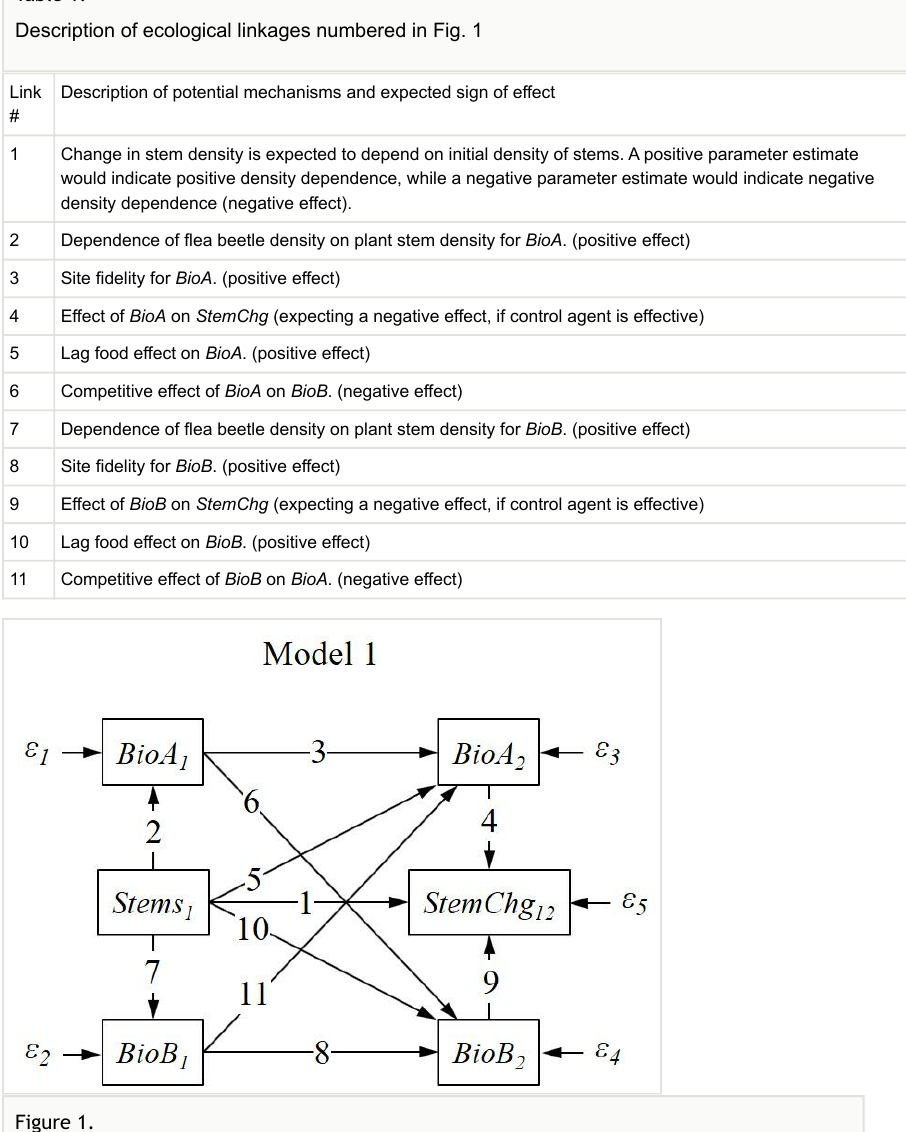
Description of ecological linkages numbered in Fig. 1